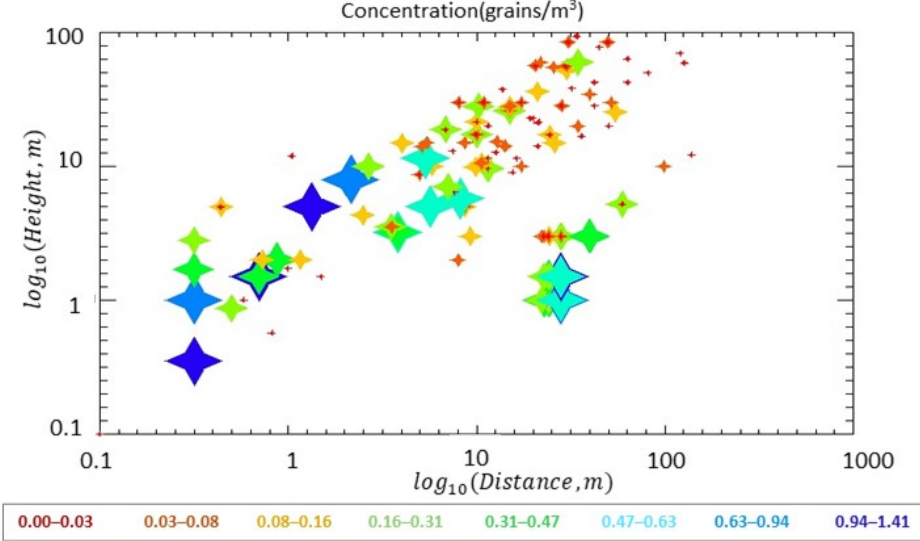
Figure 8. Variation of seed concentration (grains/m 3 ) with height and downwind distance in the Illinois field. Points at the downwind distance = 0 m were set as distance = 0.3 m for logarithm scale plotting.